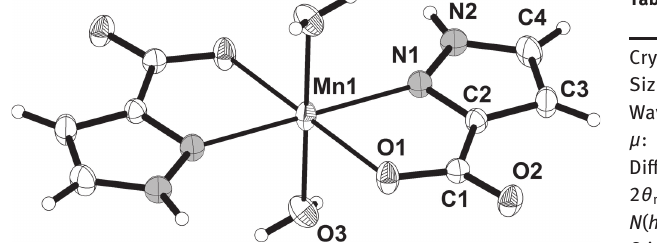
Table 1: Data collection and handling.